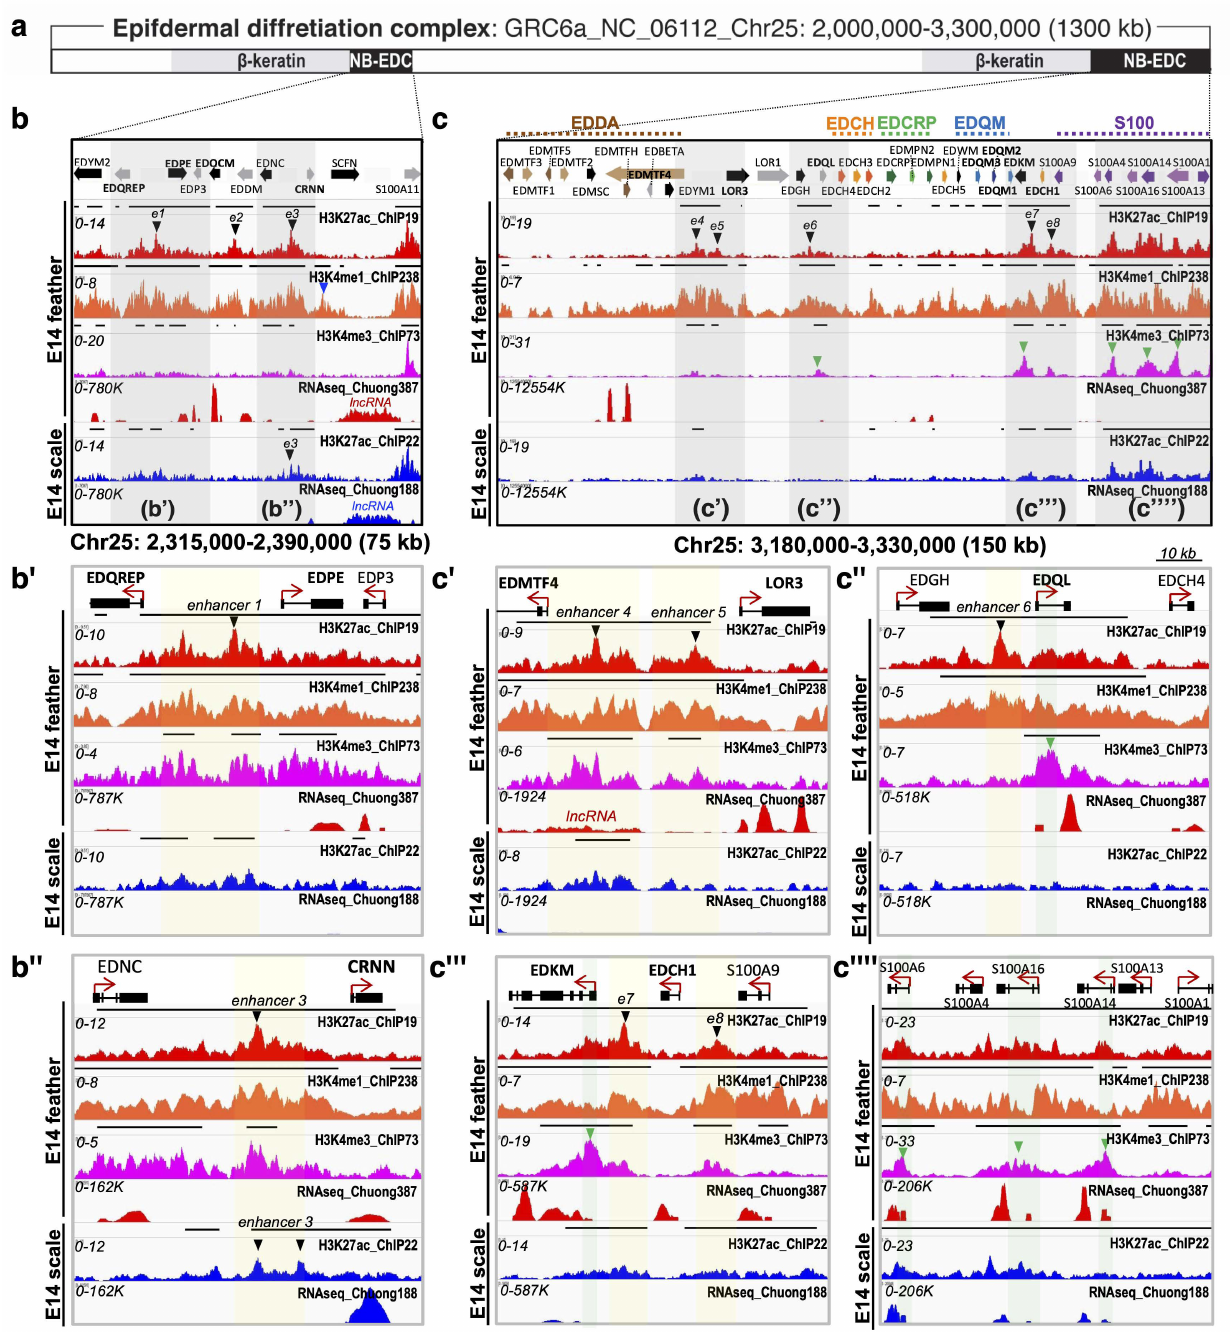
Figure 2. Epidermal differentiation complex on Chr25 with divergent epigenetic landscapes in E14 feathers and scales. ( a ) The locations of two parts of the non- β -EDC (NB-EDC) on Chr25 in the galGal6 genome version; ( b – b” ) Profiles of RNA-seq and three chromatin marks in the N-terminal part of the non- β -EDC within 75 kb of the gene start sites. ( b’ , b” ) Enlargement of the two predicted enhancer regions (enhancers 1 and 3, e1 and e3, black arrowheads) from ( b ); blue arrowhead indicates the putative poised enhancer; ( c – c”” ) Profiles of RNA-seq and three chromatin marks in the C-terminal part of the non- β -EDC within 150 kb of the transcription start site. ( c’ – c”” ) Enlargement of the five predicted enhancer regions (e4 to e8, black arrowheads) and the five predicted promotor regions (green arrowheads) from ( c ). The values on the y axis for ChIP-Seq data are input normalized intensities. The yellow color marks putative enhancer regions, while the green color marks the putative promoter regions. The gene name in bold may be under enhancer-mediated